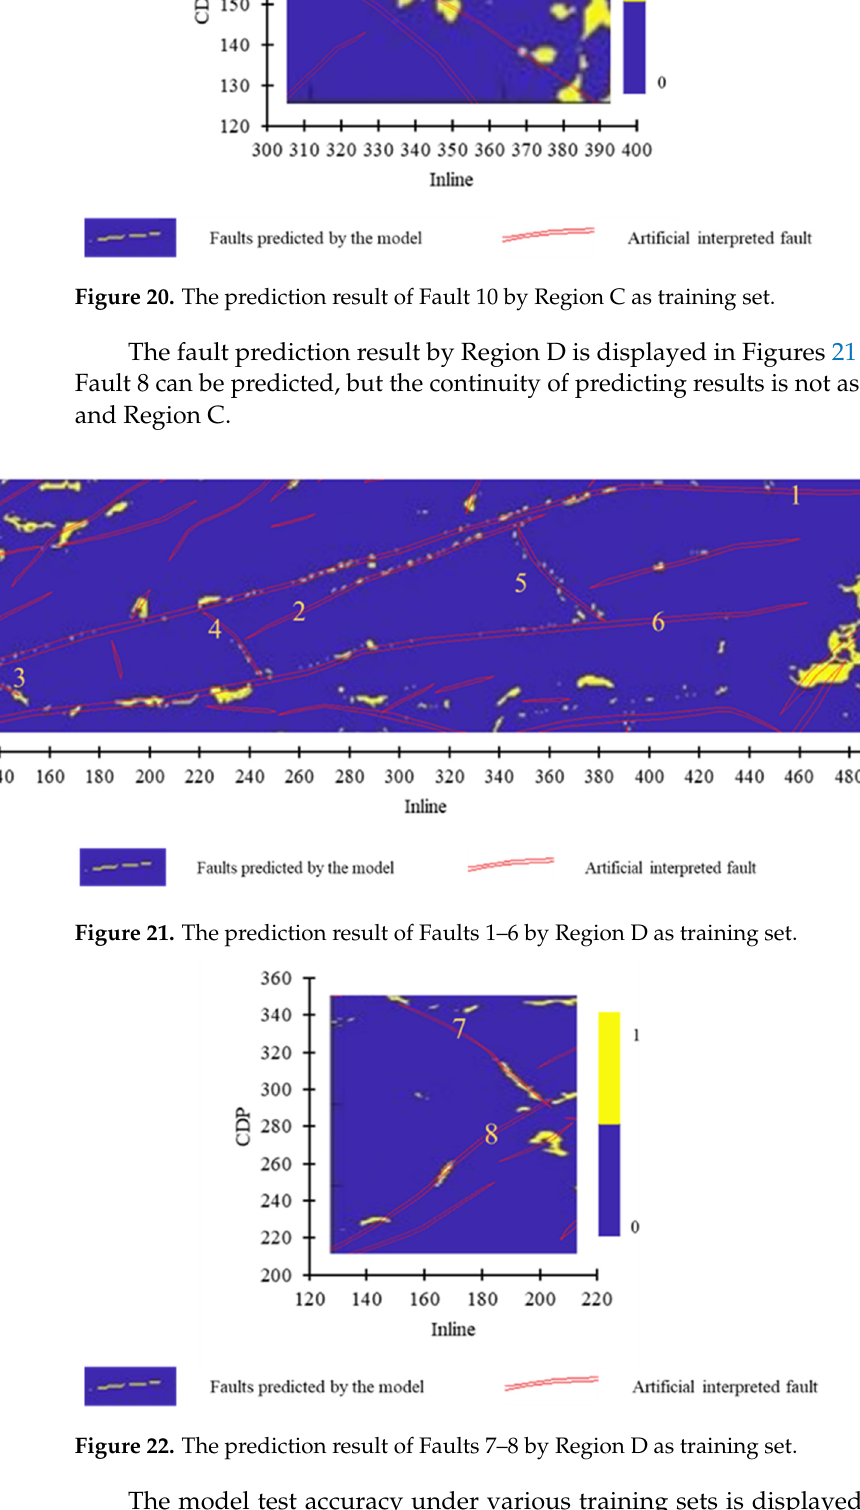
Figure 19. The prediction result of Fault 9 by Region C as training set.